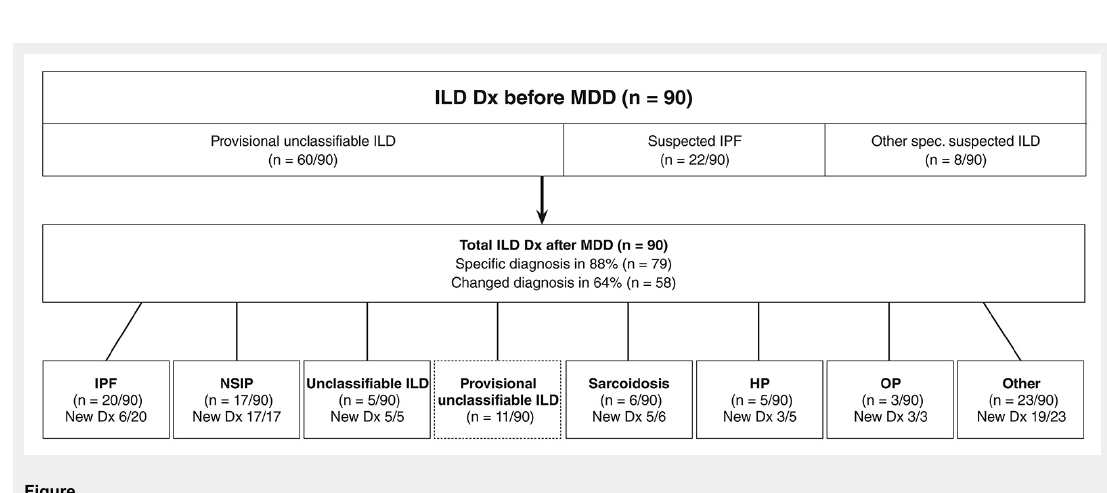
Figure Diagnosis (Dx) before and after multidisciplinary discussion (MDD) for interstitial lung disease (ILD). IPF = idiopathic pulmonary fibrosis; NSIP = nonspecific interstitial pneumonia; HP = hypersensitivity pneumonitis; OP = organising pneumonia. Other diagnosis (1–2 cases each) included: combined pulmonary fibrosis and emphysema, Langerhans cell histiocytosis, vasculitis, respiratory bronchiolitis ILD, pulmonary lymphangioleiomyomatosis, Birt-Hogg-Dubé syndrome and diffuse idiopathic pulmonary neuroendocrine cell